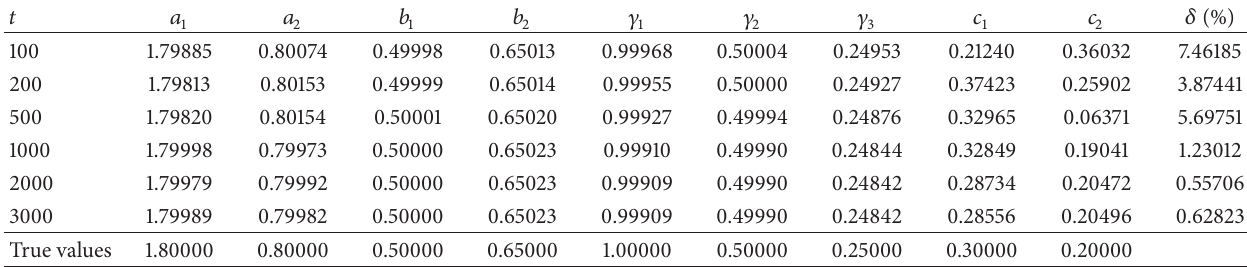
Table 2: The MISG parameter estimates and